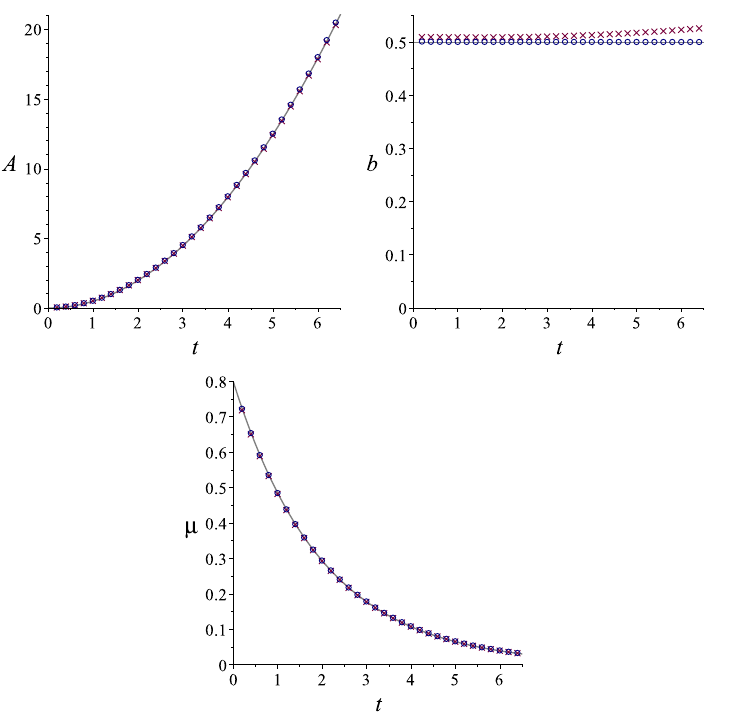
Figure 1 . Numerical estimations of A ( t ), b , (cid:22) ( t ). Red diagonal crosses represent A 59 ( t ), b 59 ( t ), (cid:22) 60 ( t ), while blue circles represent the (cid:12)rst Richardson transforms A (1) solid lines are the plots of analytic expressions